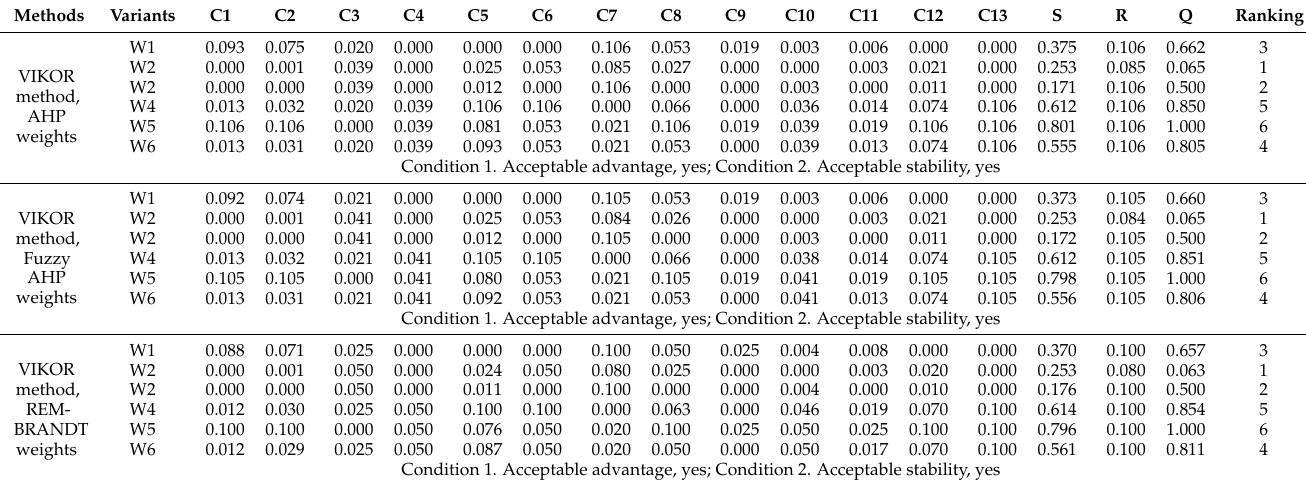
Table 12. The values of S, R, and Q metrics together with a ranking and verification of